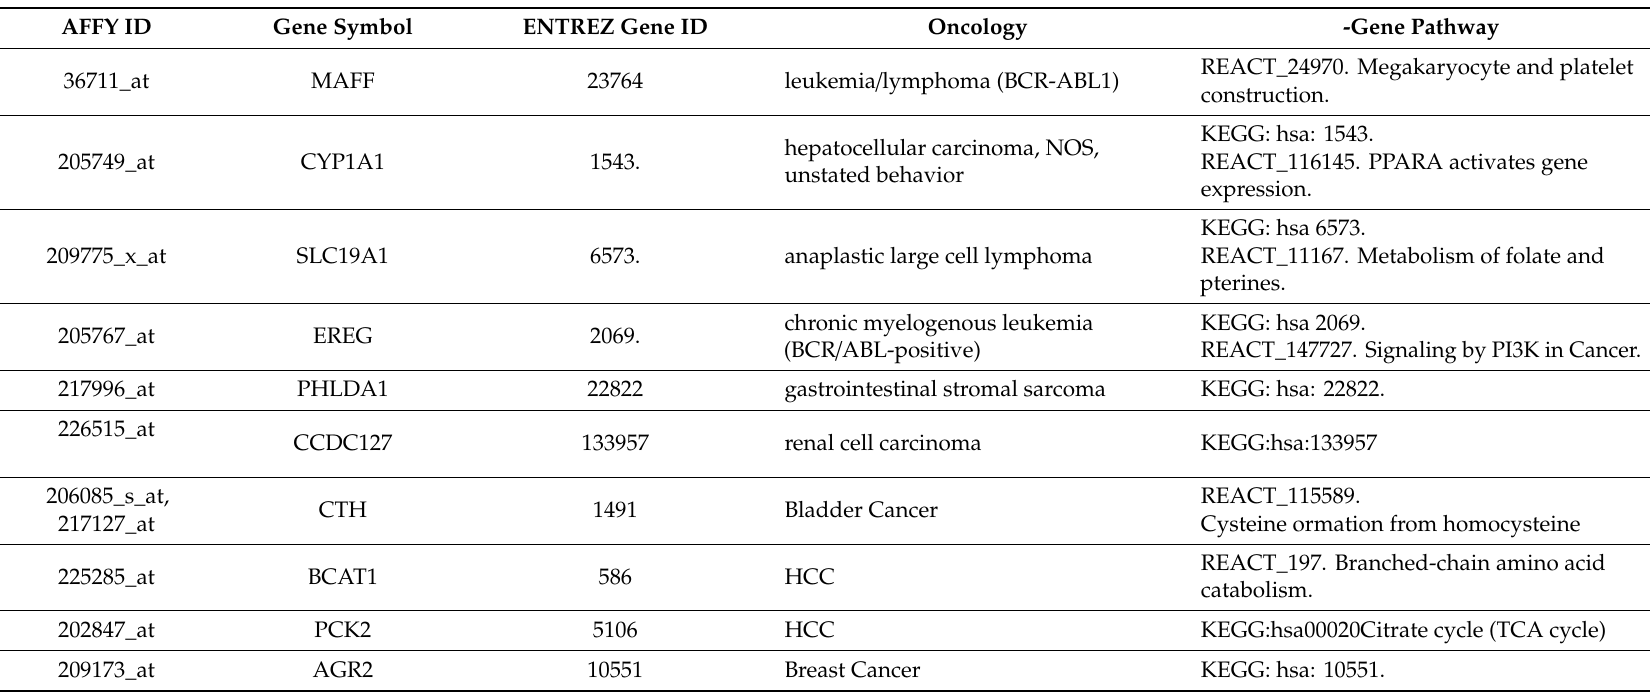
Table 3. Functional annotation of key genes detected using Euclidean distance after di ff erent periods post-infection with C